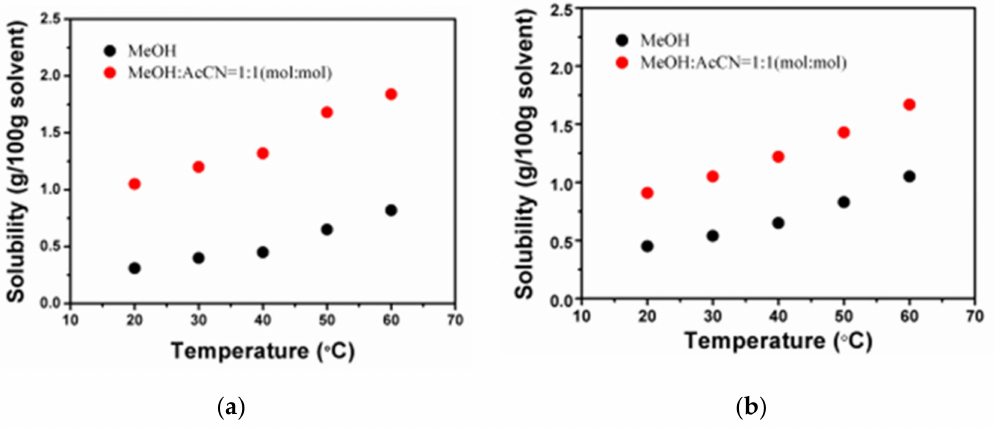
Figure 2. Solubility of the 1-TB and 2-TB in pure methanol ( a ) and methanol / acetonitrile (1:1 vol / vol) ( b ) at di ff erent